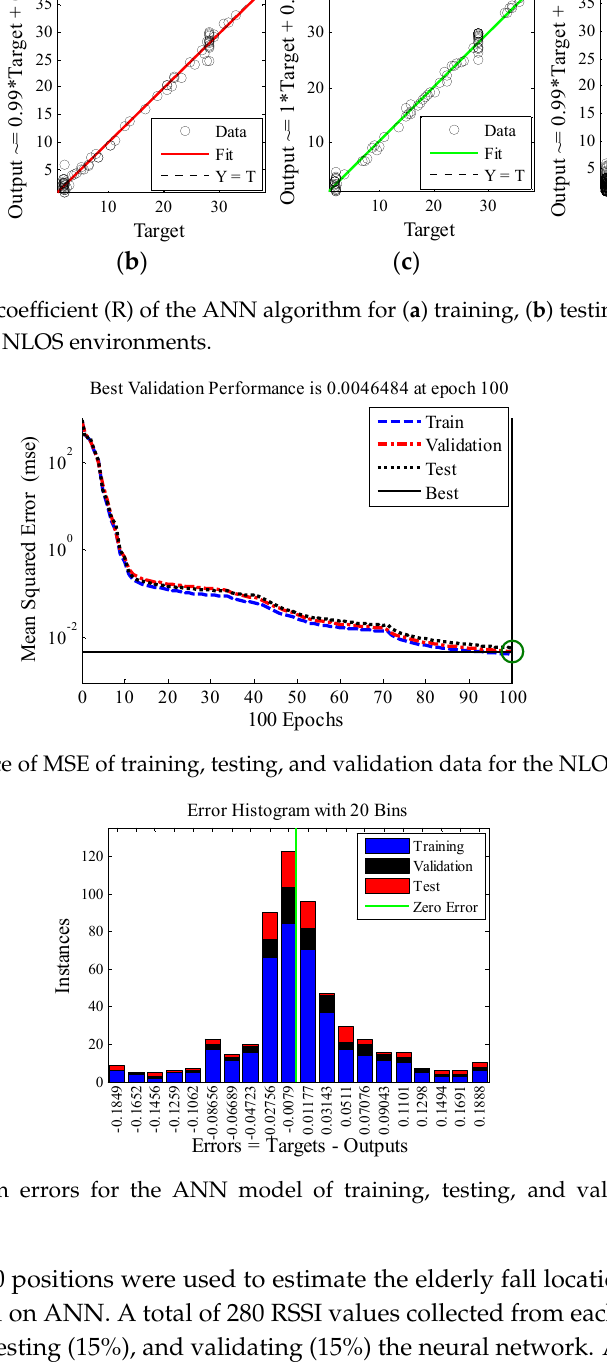
Figure 22. Histogram errors for the ANN model of training, testing, and validation data for NLOS environments.